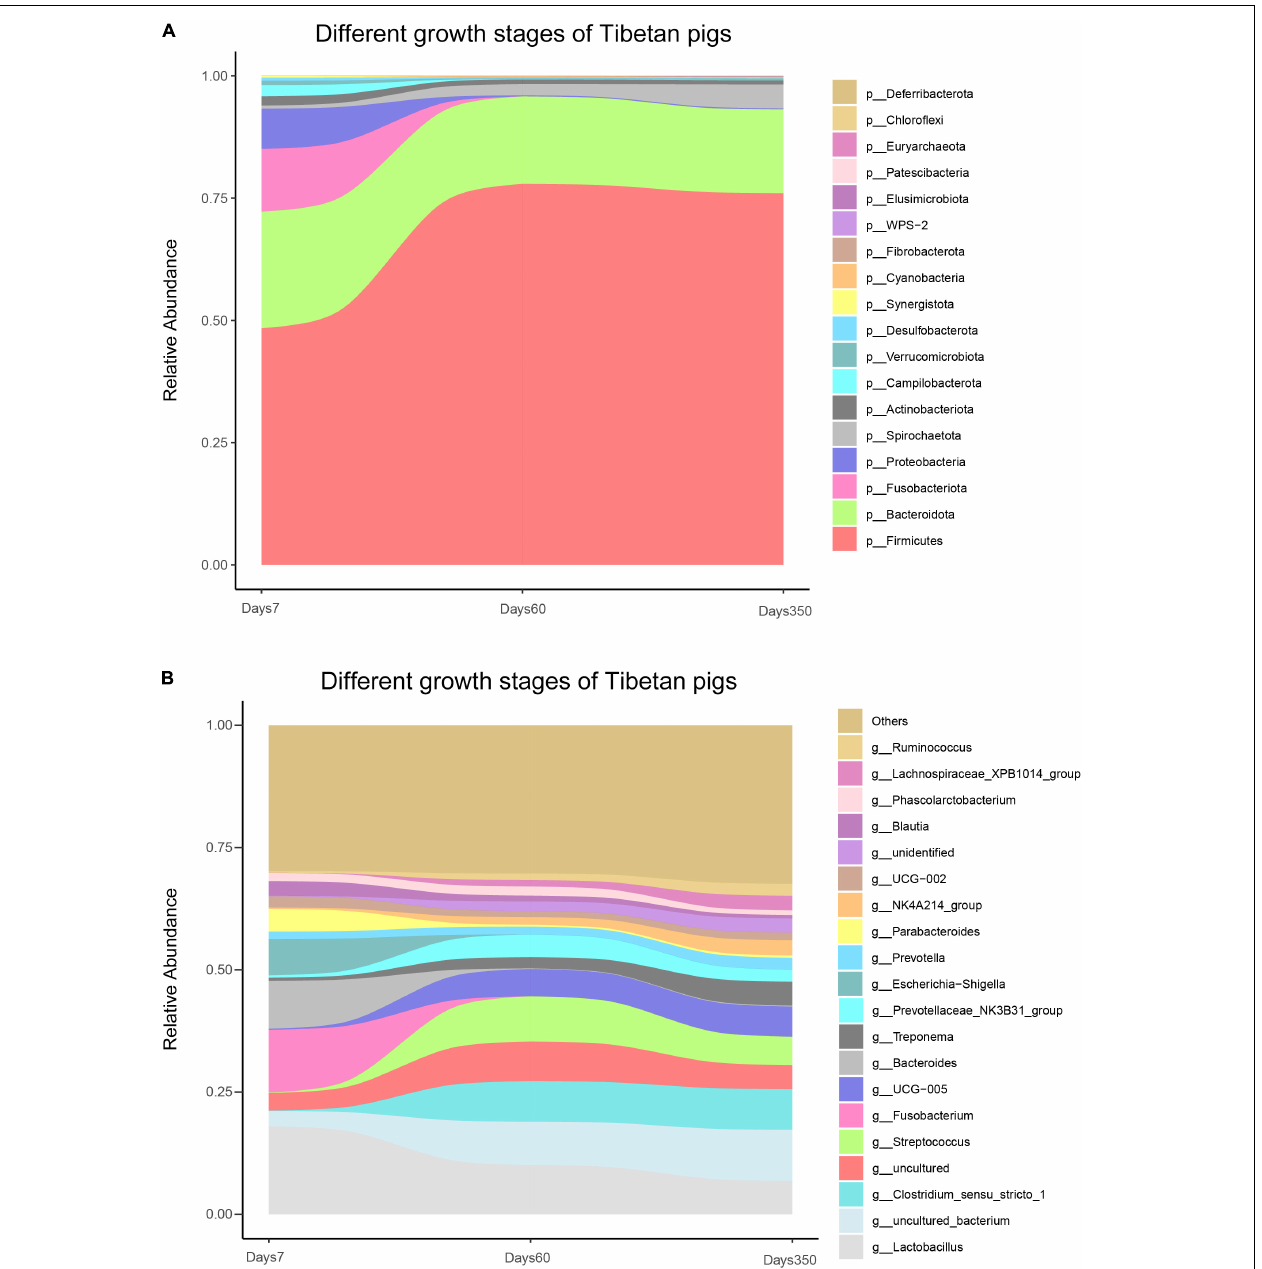
FIGURE 5 | Bacterial composition of Tibetan pigs at different growth stages. Stream-graph displaying the relative abundance of bacterial taxa in days 7, 60, and 350 of Tibetan pigs. Species composition at phylum level (A) and top 20 genus (B) . Low abundant taxa were grouped as